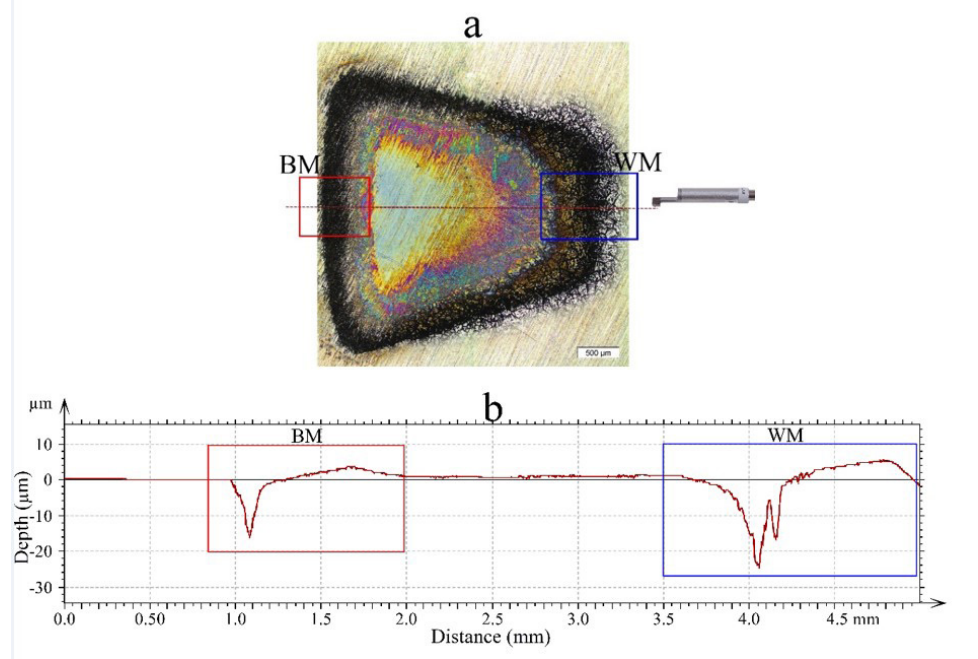
Figure 14. a. Optical micrograph of a crevice corrosion attacked site in the transition between the base metal and the weld metal in welded samples. b. 2D roughness profile measured along the dotted line.